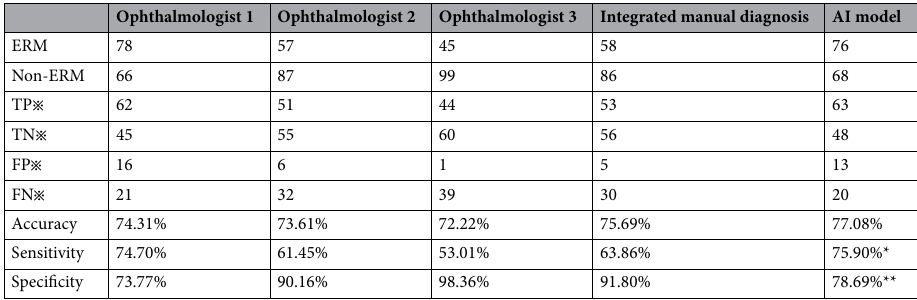
Table 3. Detailed result of different approaches.